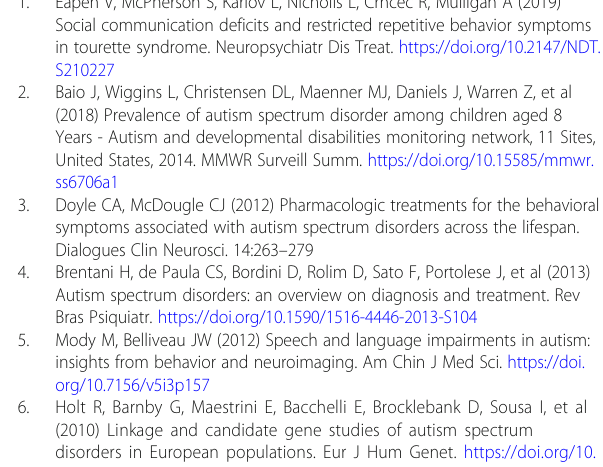
Additional file 1: Supplementary Figure 1 . Protein-protein interac- tions of CNTNAP2 with autism-relevant NrCAM, ANK2, and CNTN4 pro- teins present in sample dataset under study along with comparative gene expression levels Additional file 2: Supplementary Figure 2 . Gene mutational landscape with SFARI gene scoring for the sample cohort under investigation reveals autism genes with categorical gene